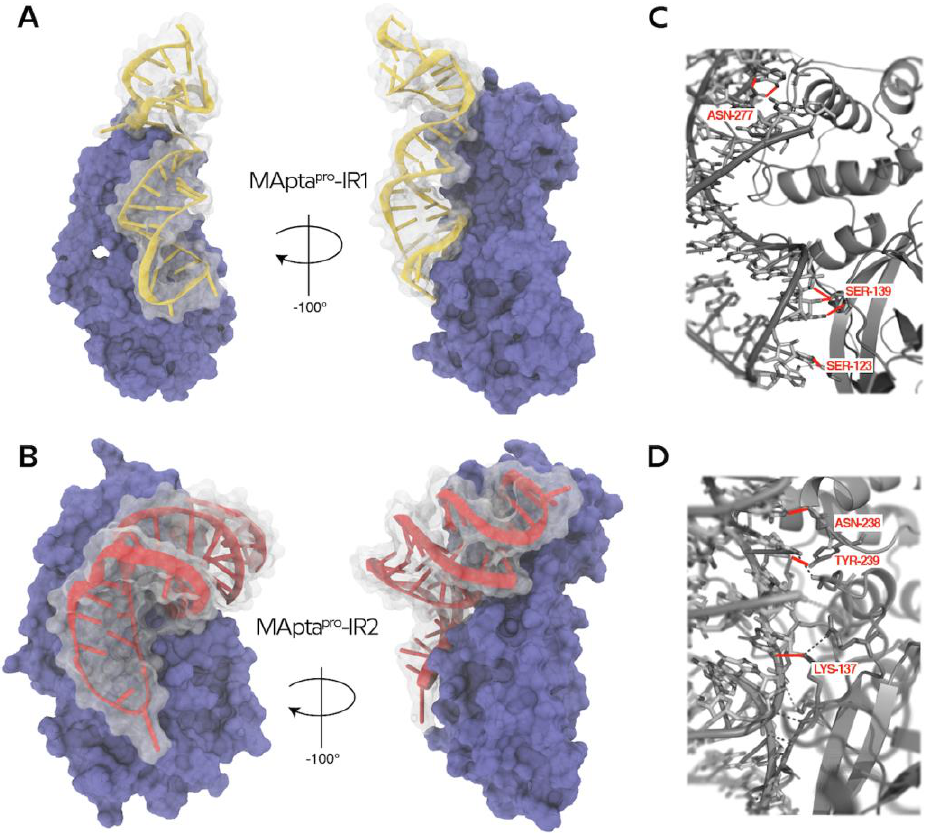
Figure 5. ( A , B ) VMD generated image of 3D-40mer aptamers MApta pro -IR1 and MApta pro -IR2, respectively, in complex with the protein M pro . ( C , D ) PyMol generated image of hydrogen bonds of the best docked pose of the selected aptamers MApta pro -IR1 and MApta pro -IR2, respectively (for detailed interaction see Figures S2 and S3 in the Supplementary File).